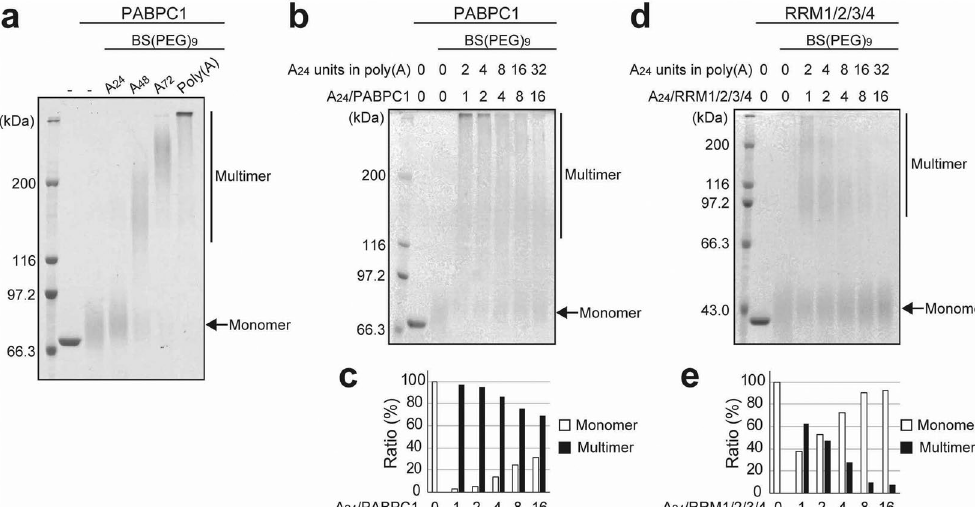
Figure 3. Chemical cross-linking of PABPC1 on poly(A). ( a ) SDS-PAGE analysis of PABPC1 after treatment with the cross-linking reagent, BS(PEG) 9 , in the presence or absence of A 24 , A 48 , A 72 , or long poly(A) ranging from 150–500 bases. ( b – e ) Chemical cross-linking of PABPC1 and RRM1/2/3/4 at each molar ratio of a 24- base unit in poly(A) over protein. SDS-PAGE analysis of the cross-linked PABPC1 ( b ) and RRM1/2/3/4 ( d ). The ratios of the monomer and the multimer at each molar ratio in PABPC1 and RRM1/2/3/4 are plotted in ( c ) and ( e ), respectively. The monomer and multimer ratios were calculated by dividing the band intensity of the monomer and the multimer by the total